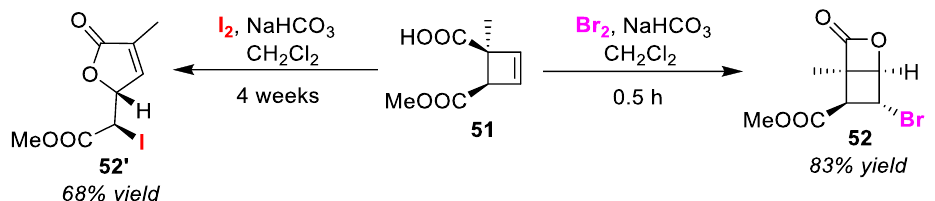
Figure 26. Halogen species-dependent selective halo-lactonizations of cyclo-betenoic acid 51 .